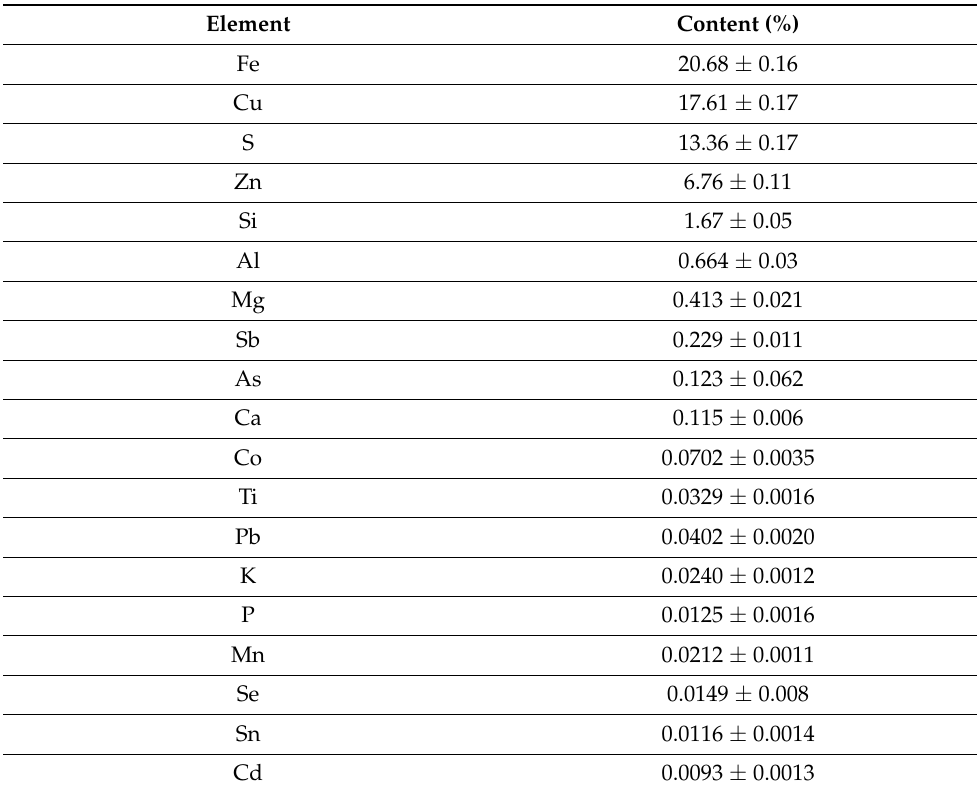
Table 3. Chemical composition of IPB